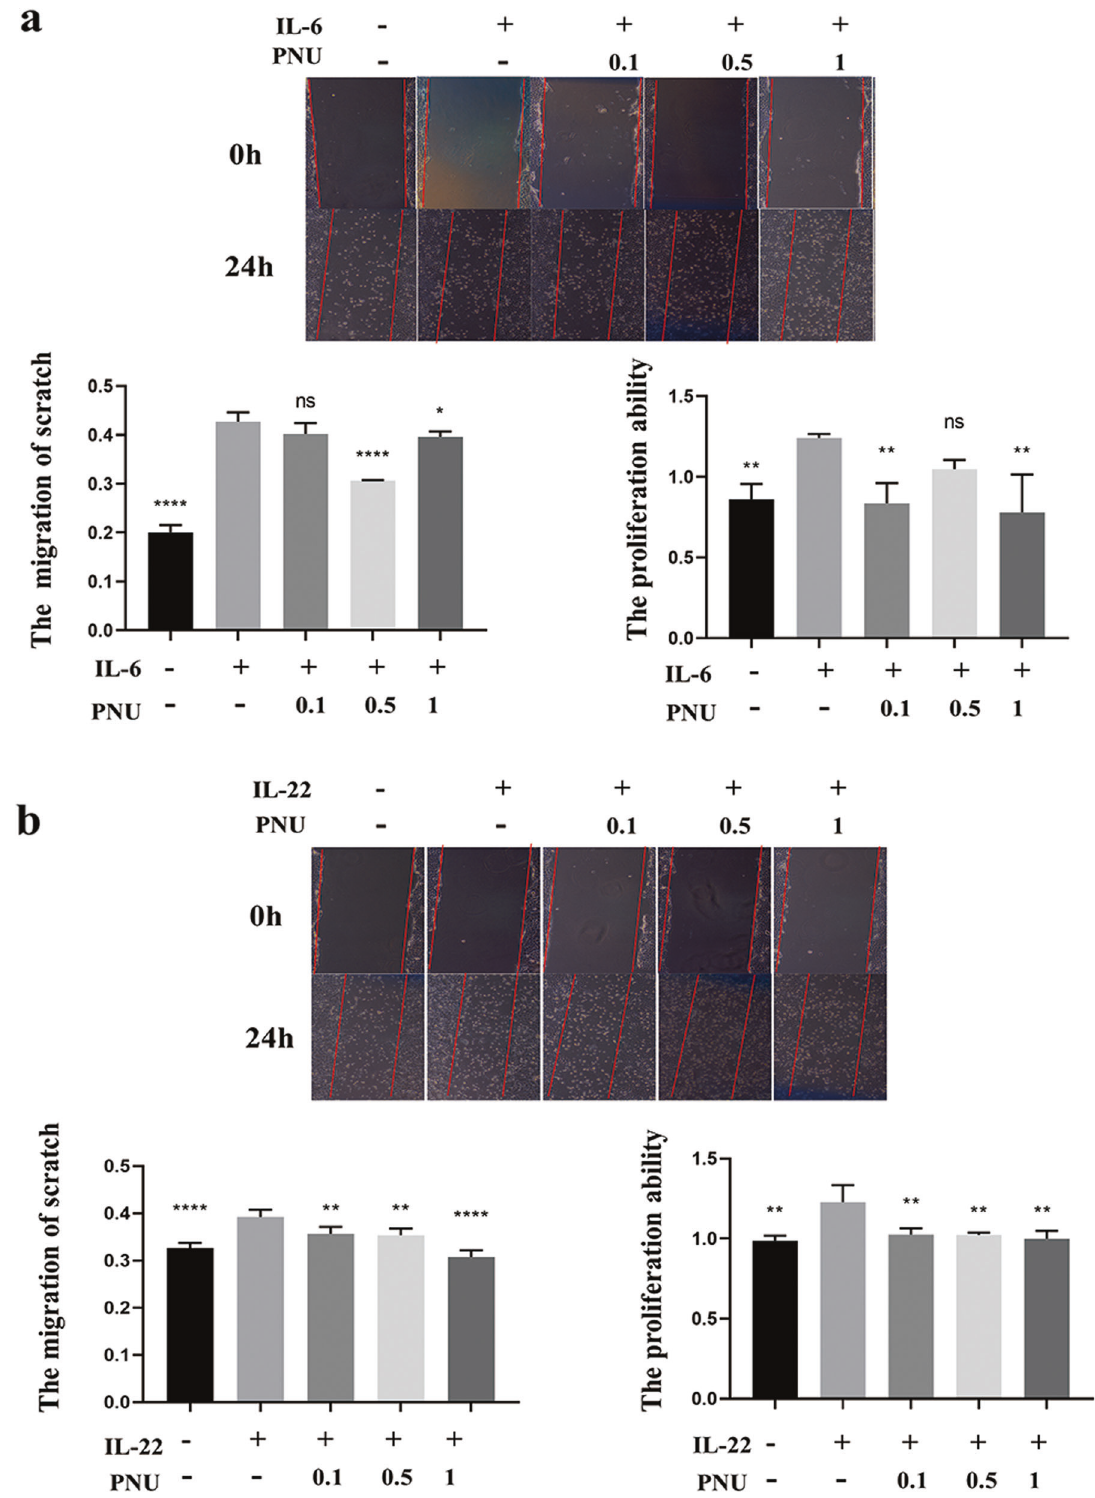
Fig. 5 PNU-282987 treatment inhibits the IL-6 or IL-22 induced keratinocyte migration. The effect of PNU-282987 treatment on IL-6 ( a ) or IL-22 ( b ) induced cell migration was analyzed by in vitro scratch ‐ wound assay, which were established in IL-6 ‐ treated and untreated HaCaT cells. Scratch ‐ wound assay result was analyzed and the percentage of closed wound area is presented in the graph.